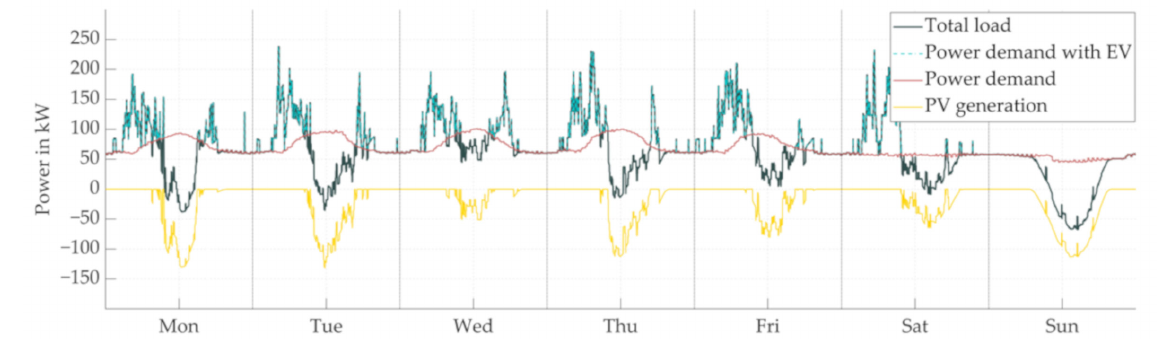
Figure 20. The control algorithm for model